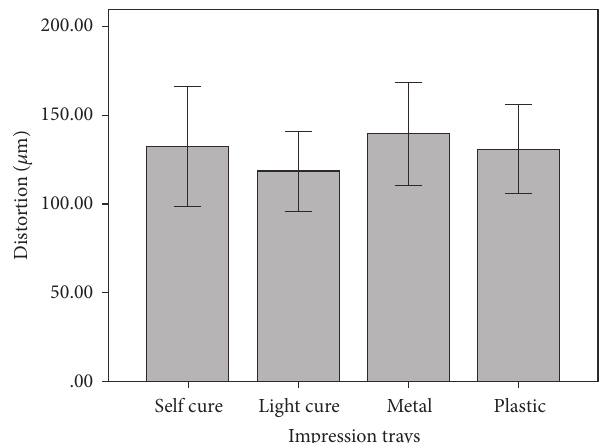
Figure 6: Descriptive mean analysis of test impression materials ( 𝜇